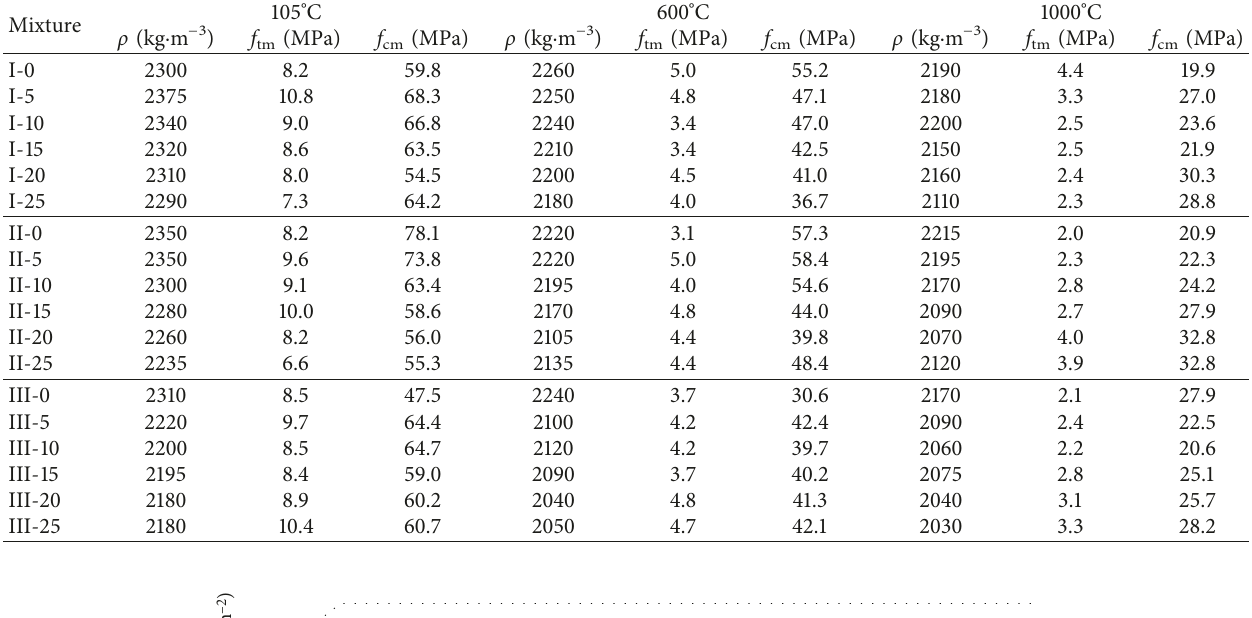
Table 3: Detailed results of bulk density, flexural strength, and compressive strength.